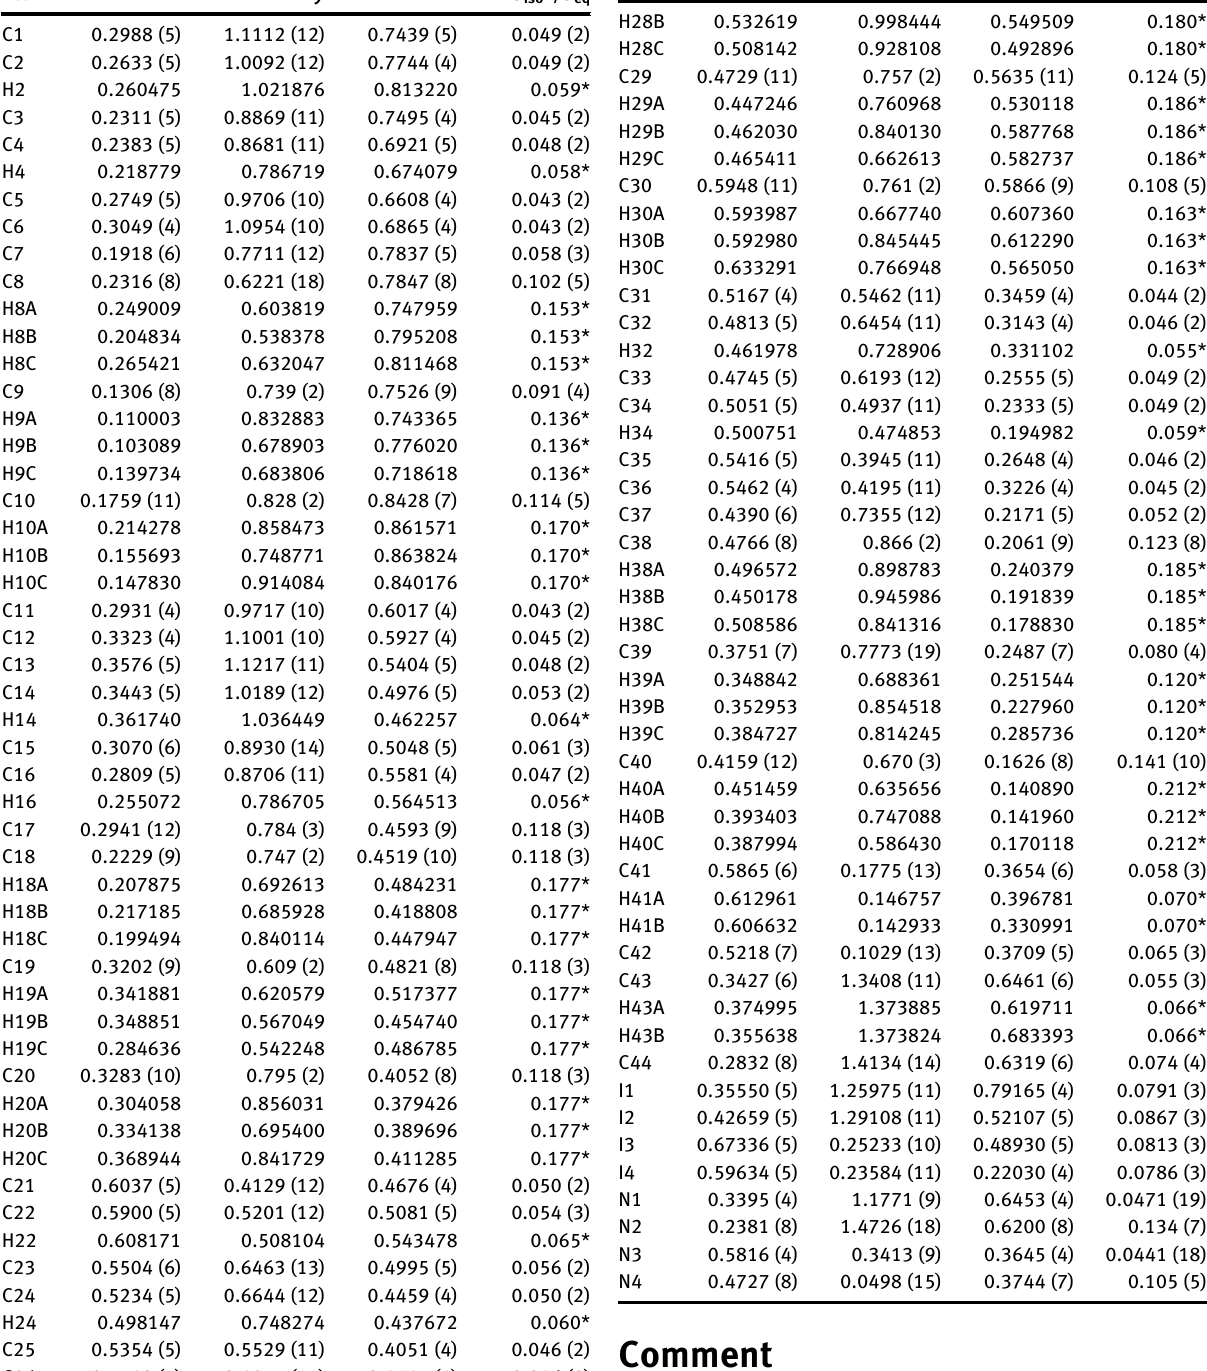
Table  : Fractional atomic coordinates and isotropic or equivalent isotropic displacement parameters (Å 